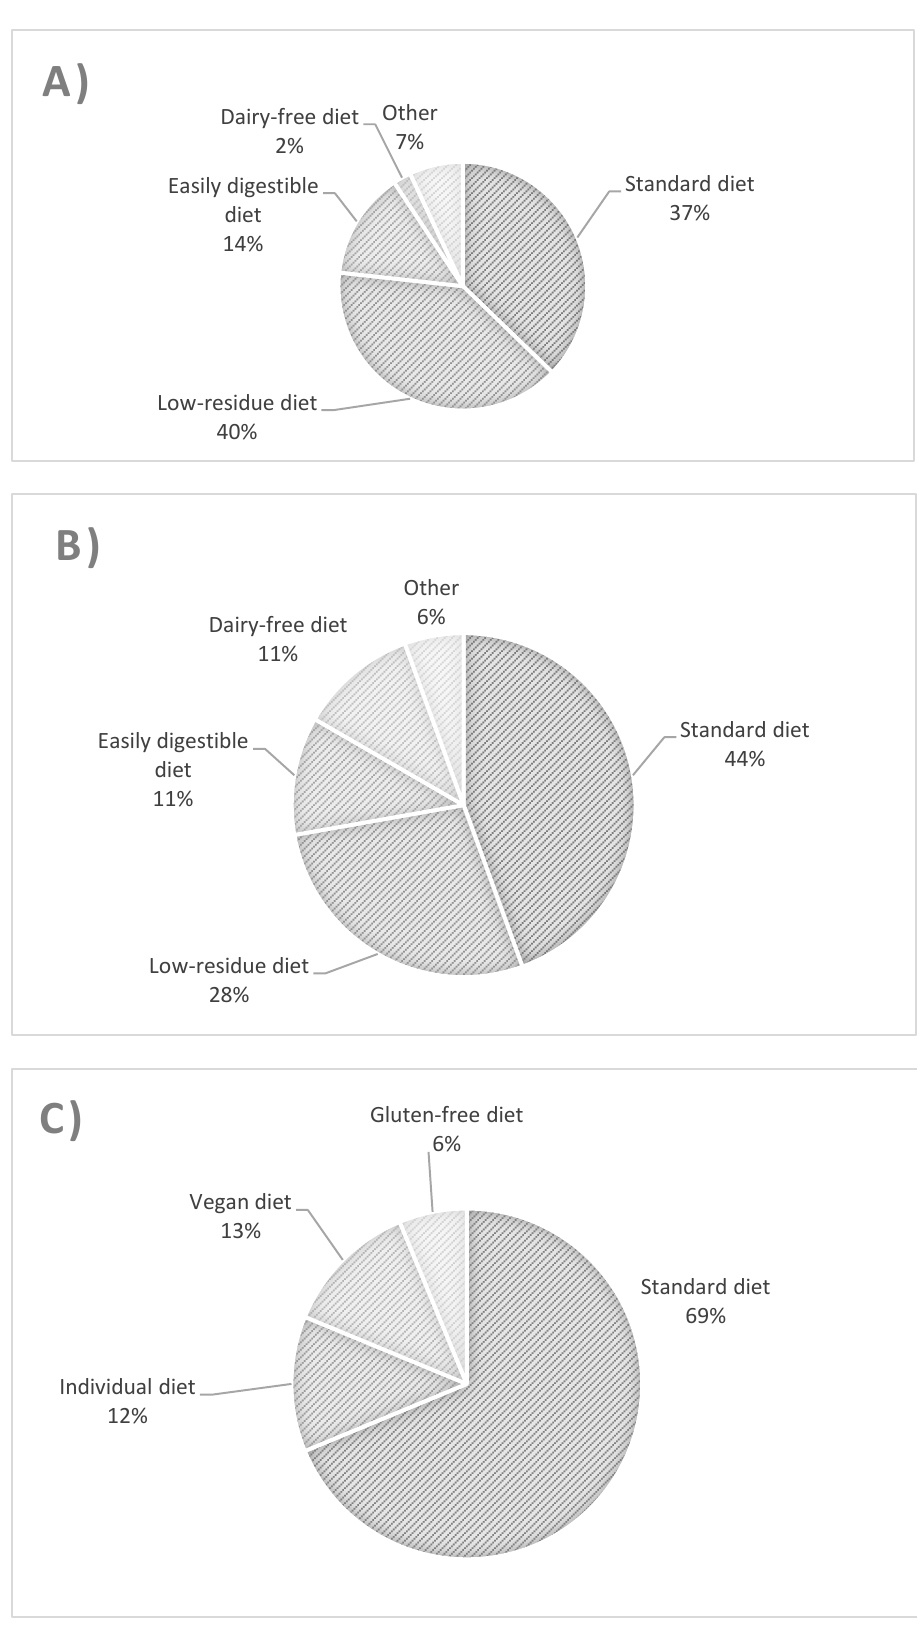
Figure 1. Types and percentage of diets used in patients with ulcerative colitis ( A ), Crohn’s disease ( B ), and controls ( C ).